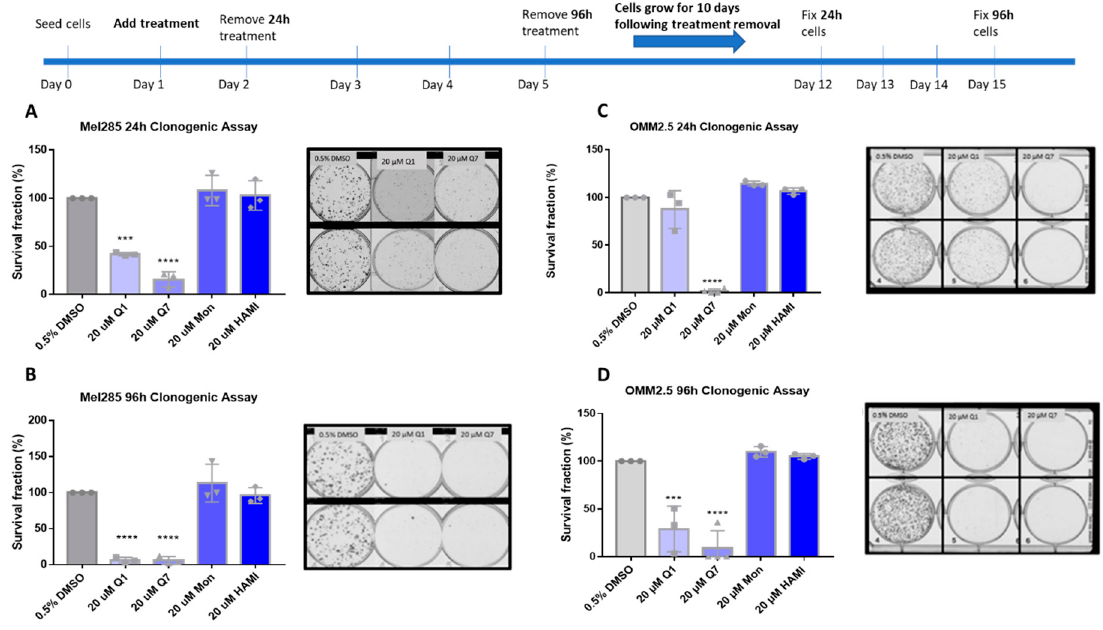
Figure 6. Quininib and 1,4-dihydroxy quininib reduce colony formation in Mel285 and OMM2.5 cells. Graphs show the percentage survival fraction of clones at 24 ( A , C ) and 96 h ( B , D ) post treatment with quininib (Q1), 1,4-dihydroxy quininib (Q7), montelukast (Mon), or HAMI 3379 (HAMI). Images of clones captured by GelCount™ system (Oxford Optronix) after 10 days of culture following treatment with DMSO control or 20 µM quininib (Q1) or 20 µM 1,4-dihydroxy quininib (Q7) for 24 or 96 h. Clones were stained with 0.5% crystal violet before counting. 1500 cells (Mel285) or 9000 cells (OMM2.5) were seeded and treated in duplicate in 6-well plates for each individual experiment and individual experiments were conducted three times ( n = 3). Statistical analysis was performed by ANOVA with Dunnett’s post hoc multiple comparison test. Error bars are mean + S.E. *** p < 0.001; **** p < 0.0001.